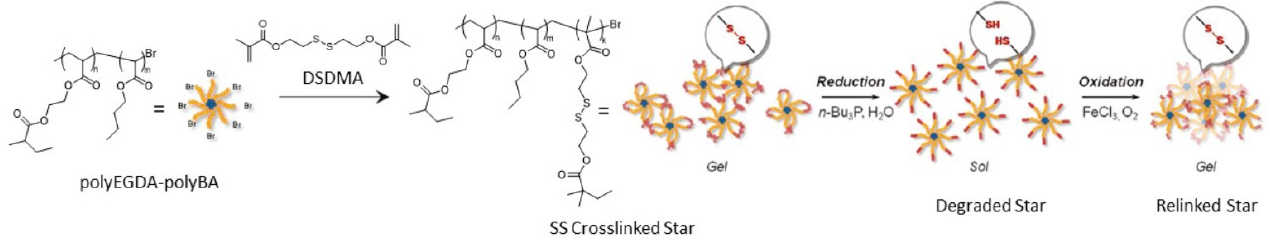
Figure 13. Synthetic methodology to incorporate DSDMA on polyEGDA-polyBA stars and their redox behavior. ATRP was used to synthesize polyEGDA-polyBA, generating a core-crosslinked star polymer macroinitiator (synthesis not shown). Adapted with permission from [83]. Copyright (2010) American Chemical Society.